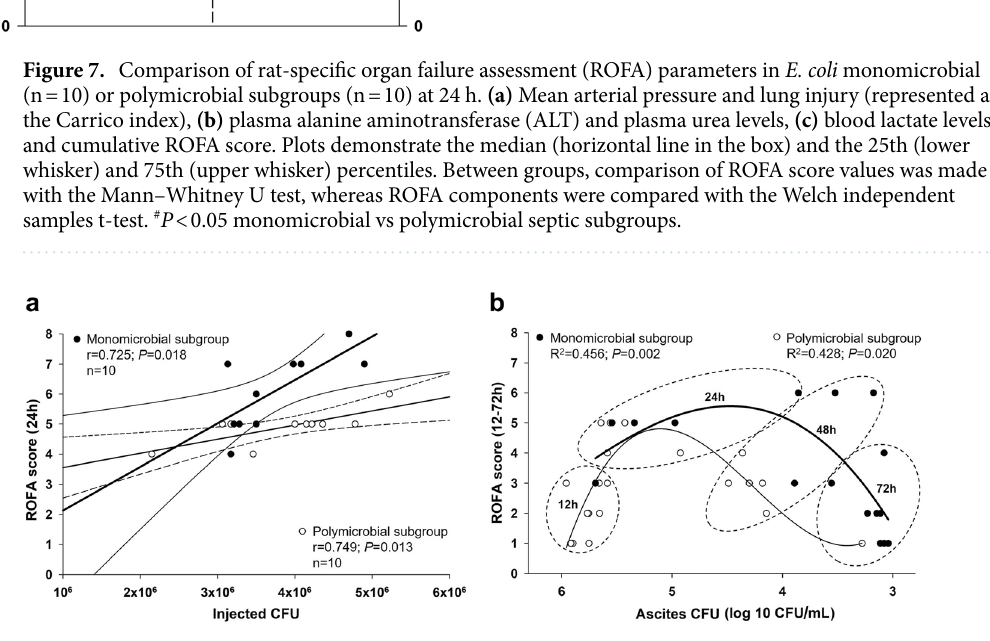
Figure 8. Correlations between inoculum and ascites CFU and ROFA score values in mono- or polymicrobial subgroups. (a) Correlations between CFU values for the mono- or polymicrobial inducer inoculum and ROFA scores at 24 h of sepsis. The E. coli monomicrobial subgroup (n = 10) is marked with black circles, a thick regression line and a thin line for the 95% confidence interval, whereas the polymicrobial subgroup (n = 10) is indicated with open circles, a thin regression line and a dashed line for the 95% confidence interval. Pearson’s product correlation coefficient r values, (null hypothesis-related) P values and numbers of animals involved in the subgroup analysis are provided. (b) Relationship between the log 10 CFU values for ascites and ROFA score values in all septic groups. The number of animals in the various sepsis groups is indicated in Table 1. Evolving predominance of ascites monomicrobial (black circles) vs polymicrobial (open circles) content and reduced CFUs in ascites over time. Polynomial regression curves of the polymicrobial and monomicrobial ascites samples are marked with a thin and a thick line, respectively. Third-order polynomial curve fit values (R 2 and P ) are indicated. Data belonging to different stages of sepsis are illustrated with dashed